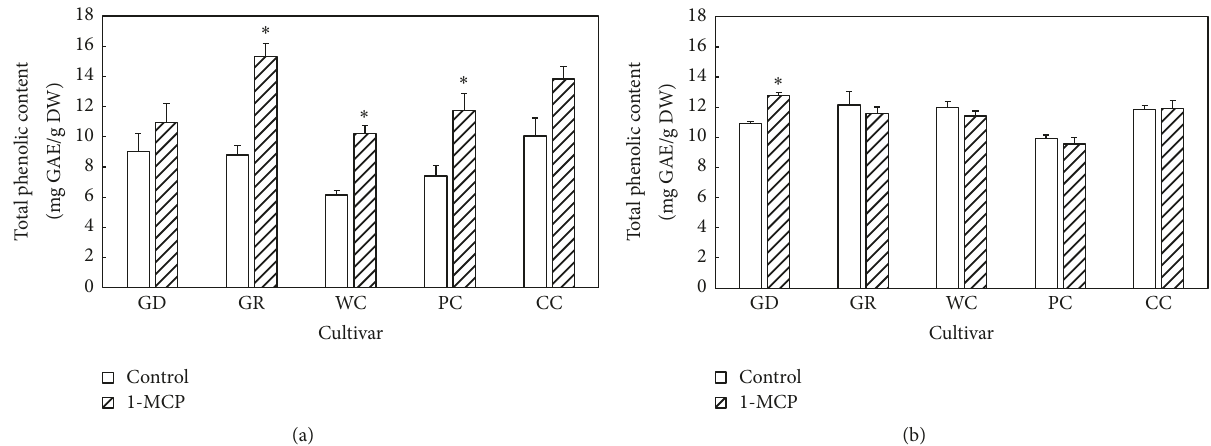
Figure 4: Total phenolic content of apple fruit at (a) 70 or (b) 140 days of storage at 0 ∘ C followed by 7 days at 20 ∘ C. GD, “Golden Delicious”; GR, “GoldRush”; WC, “WineCrisp”; PC, “Pixie Crunch”; CC, “CrimsonCrisp.” Asterisks ( ∗ ) indicate significant difference between control and 1-MCP treatment in each cultivar at each storage duration treatment by Student’s 𝑡 -test at 𝑝 < 0.05 . Vertical bars represent standard error ( 𝑛 = 4